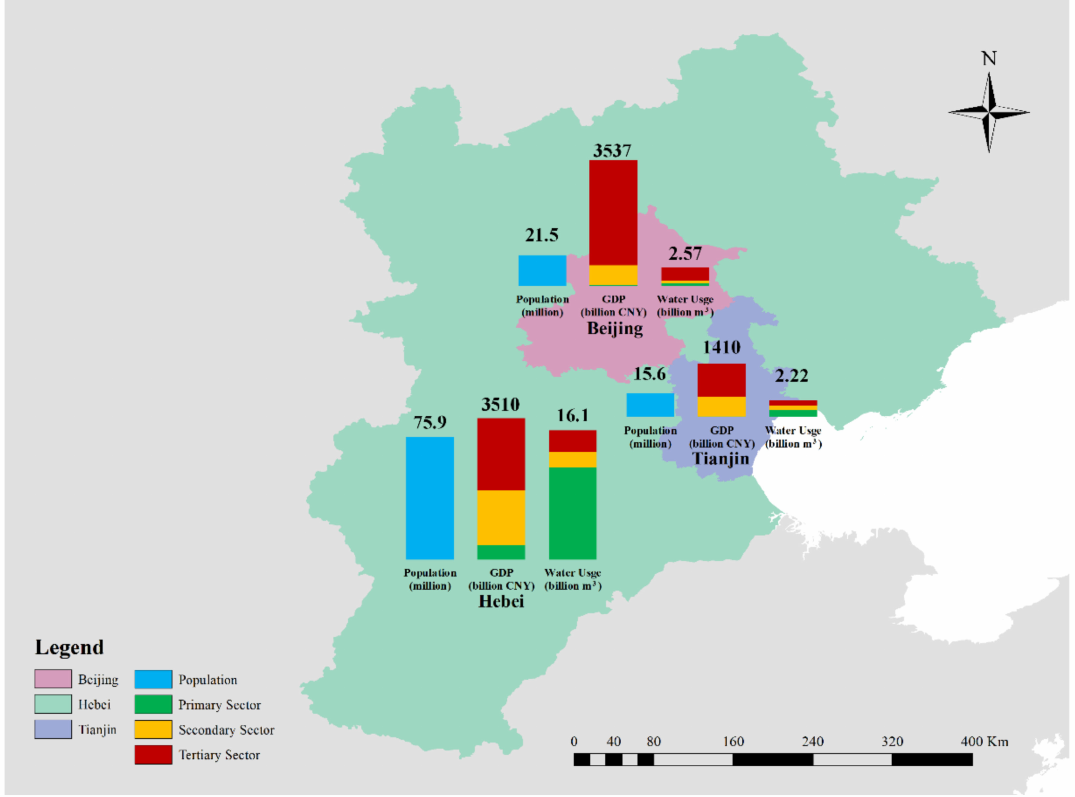
Figure 1. Location of the BTH